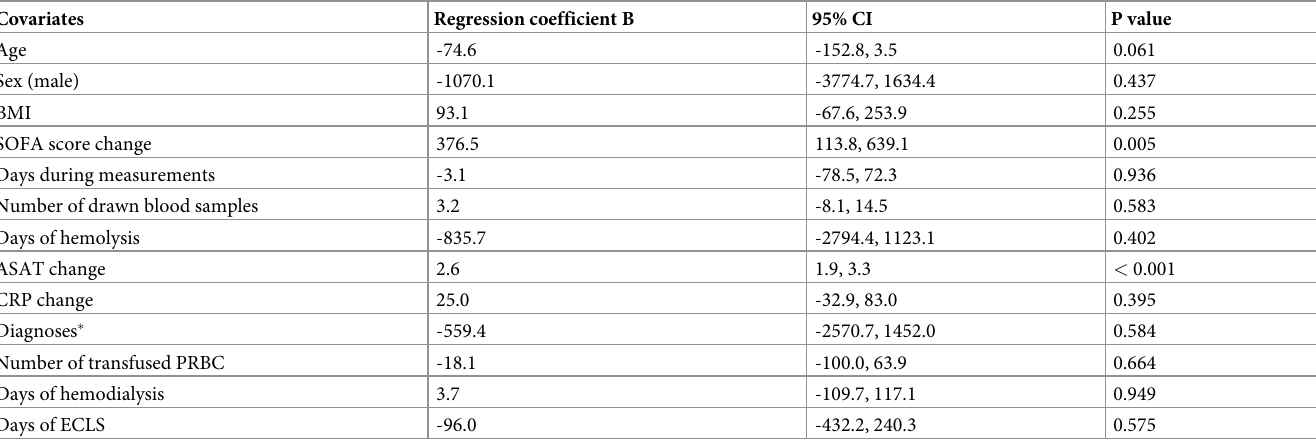
Multivariable linear regression analysis was performed with ferritin change between first and last ferritin measurement as dependent variable (R 2 = 0 . 225; All variance inflation factors < 7) . ASAT , aspartate aminotransferase; BMI , Body mass index; CI , confidence interval; CRP , c-reactive protein; ECLS , extracorporeal life support; PRBC , packed red blood cells; SOFA , Sequential organ failure assessment . � Others/sepsis/septic shock